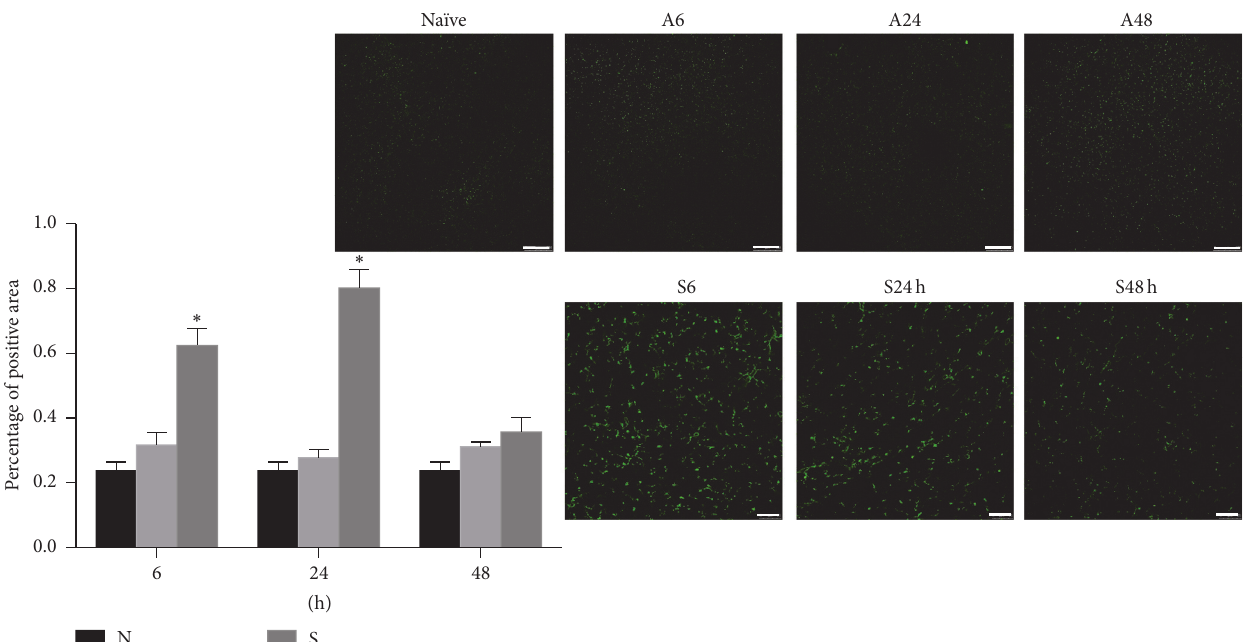
Figure 3: Microglia activation after surgery. Low levels of CD11b immunoreactivity were detected in the na¨ıve and anesthesia groups at any time points studied. In contrast, an intensive number of CD11b positive cells were detected in the hippocampus at 6h and 24 h after surgery in the surgery group. At 48 h after surgery, the proportion of CD11b positive cells was comparable in the surgery group and anesthesia group. The percentage of positive area was measured by ImageJ. Compared with the na¨ıve group, it increased significantly in the surgery group in the 6 and 24 hours after surgery. N: na¨ıve group; A: anesthesia group; S: surgery group. ∗ 𝑝 < 0.05 compared with the na¨ıve